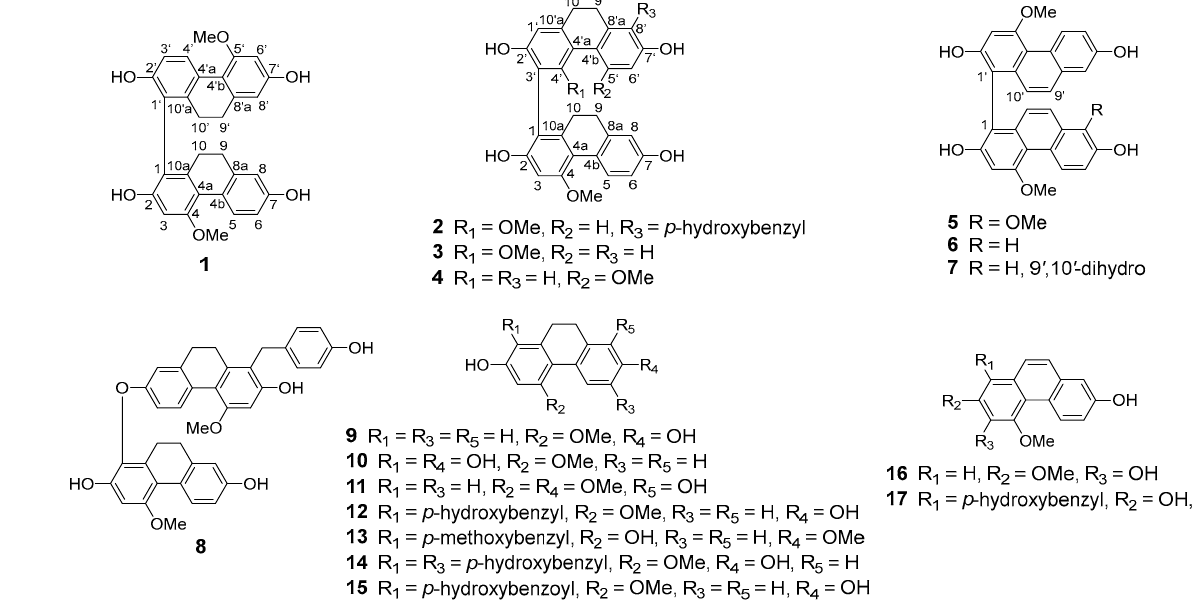
Figure 1. Structures of phenanthrenes 1 – 17 from B. striata